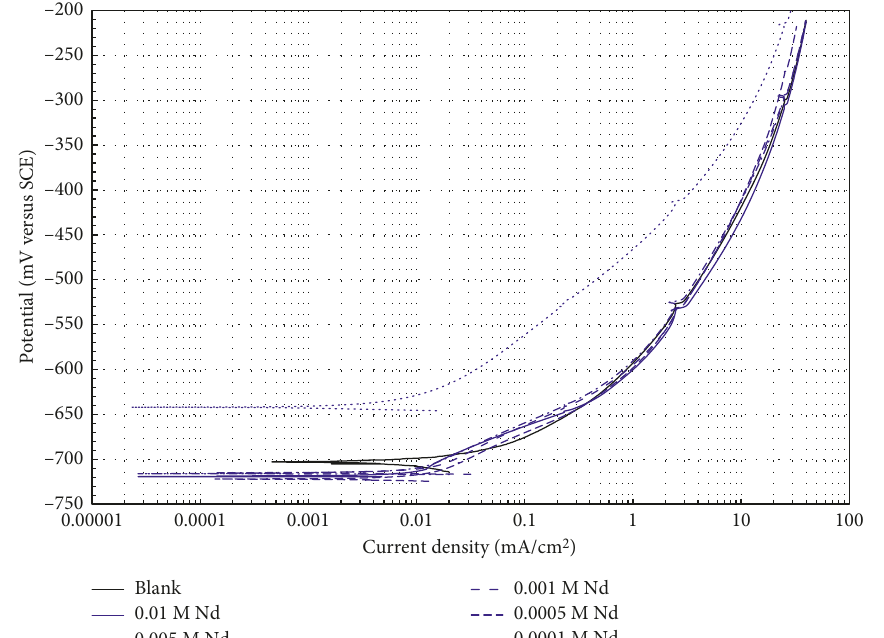
Figure 1: Anodic polarization curves for API X70 steel in 3.5% NaCl solution at different concentrations of Nd 3+ ions (0.1667mV · s − 1 ).